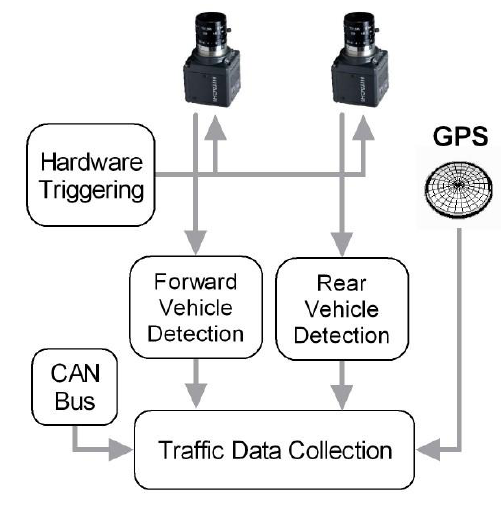
Figure 2. Overview of the traffic data collection sensor